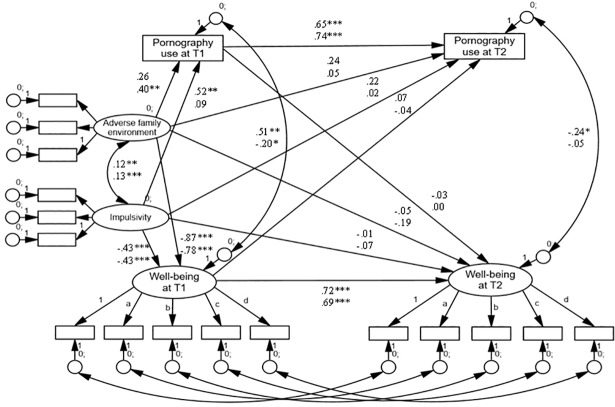
Final cross-lagged path model (Model 2) of the association between
adolescent pornography use and well-being in the Rijeka panel.Notes. Model fit:
χ2(262) = 583.26, CFI = .945,
RMSEA = .038; unstandardized paths and covariances in the male sample
are presented in the top row and those in the female sample in the
bottom row. * p < .05, ** p <
.01, *** p < .001.